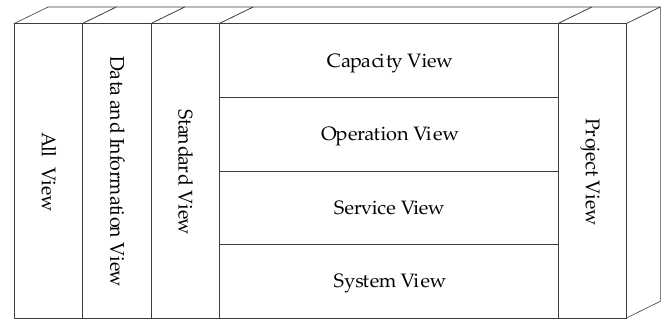
Figure 6. Architecture views in the Department of Defense Architectural Framework 2.0 (DoDAF2.0).